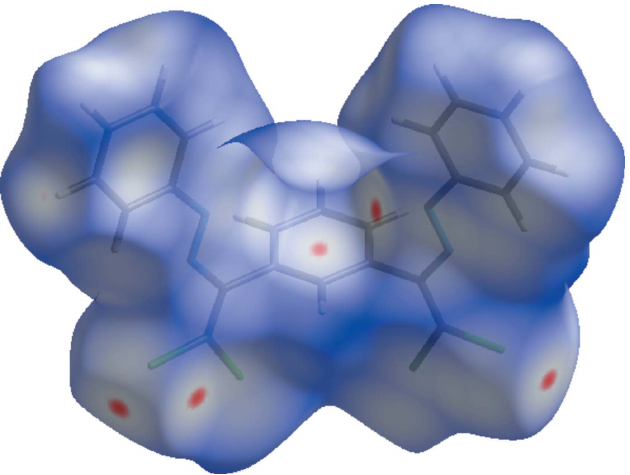
Figure 4 View of the three-dimensional Hirshfeld surface of the title compound plotted over d norm in the range (cid:4) 0.0453 to 1.4337